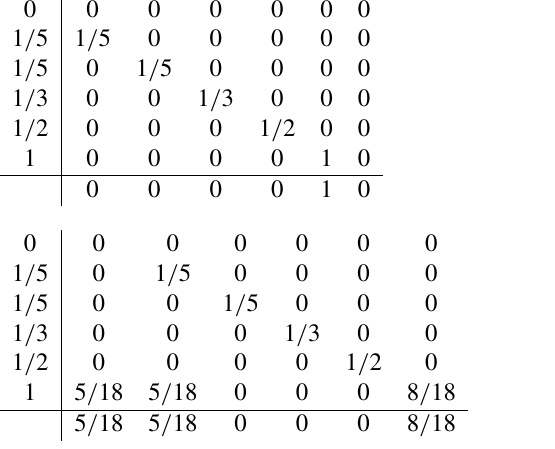
We plot three stability diagrams for the M1 scheme: Fig. 2a, with axes (k x (cid:49)t,k z (cid:49)t) ; Fig. 2b, with axes (T x ,(cid:49)t) for the 2-D acoustics the system of Eq. (27); and Fig. 2c, with axes (T x ,(cid:49)t) for the system of normal modes (Eqs. 12–16). In Fig. 2a, the x axis k x (cid:49)t varies from 10 − 4 to 10 0 . 1 and the y axis k z (cid:49)t varies from 10 − 4 to 10 2 . In each dimension, we use 100 logarithmically spaced points. As in Lock et al. (2014) and Steyer et al. (2019), for each pair of k x (cid:49)t and k z (cid:49)t , the spacetime operator from Eq. (27) is computed us- ing IMEX M1 method given by tables (29). Figure 2b and c use the horizontal wavenumber k x that cor- responds to the wavelength T x . In the figures, T x varies from approximately 2 to 220 km, with 100 logarithmically spaced points. Since the acoustic system of Eq. (27) requires k z , for Fig. 2b we make k z span the range K 0 = k x ×[ 10 − 2 , 10 4 ] . On the y axis, the time step varies from 0.5 to 400 s, again with 100 logarithmically spaced points. For each pair of (k x ,(cid:49)t) , we compute a set of spacetime operators based on k z ∈ K 0 via the same procedure as for Fig. 2a. If for each k z the op- erator is stable, then point (T x ,(cid:49)t) is stable in Fig. 2b. We chose to use wavelength on the x axes of the stability dia- grams, rather than wavenumber, to make it easier to identify horizontal